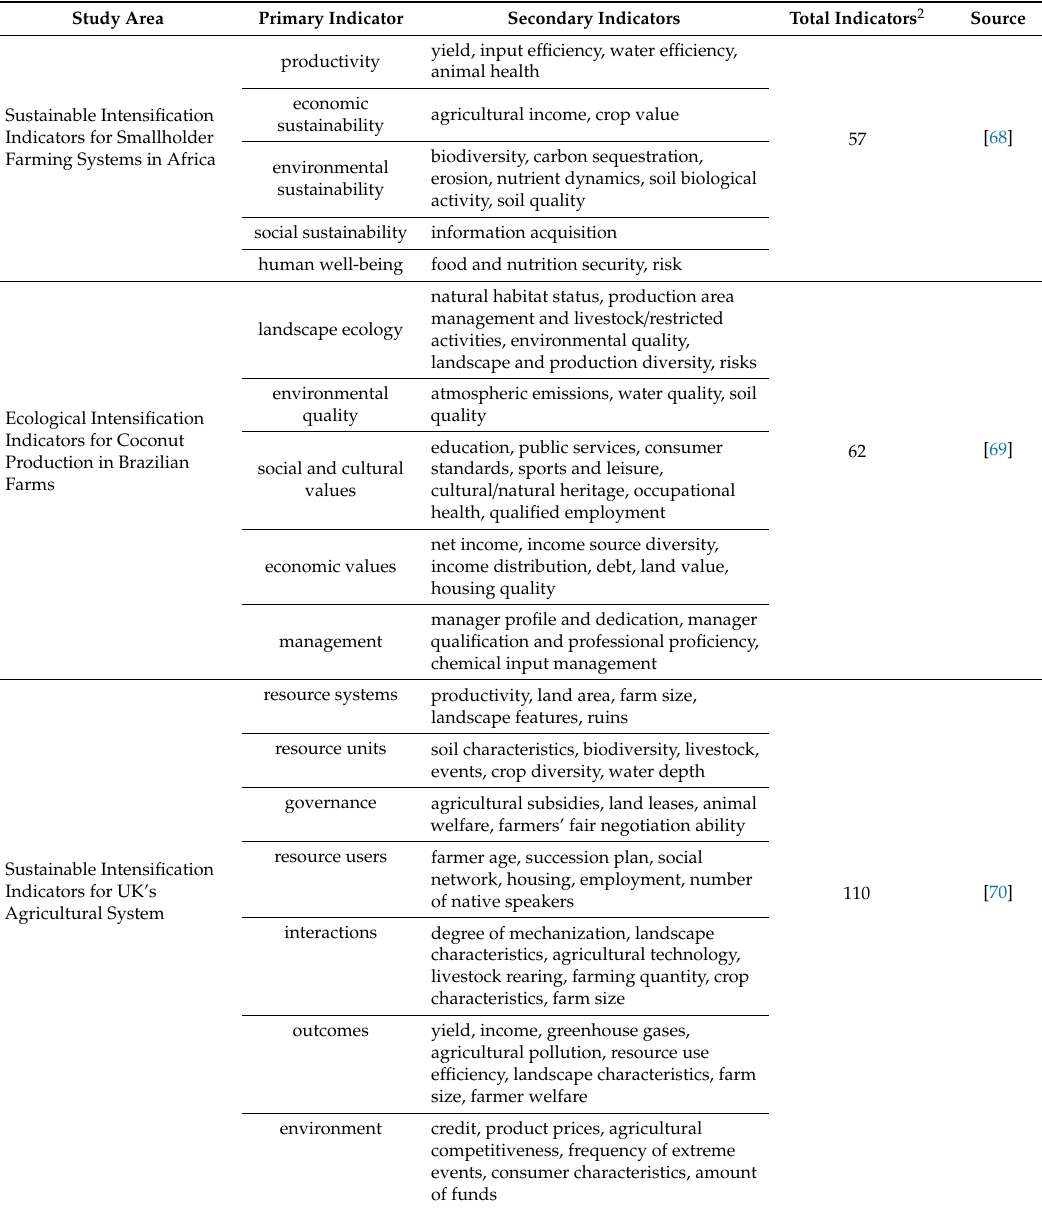
Table A1. Summary of the current agricultural sustainable intensification indicator